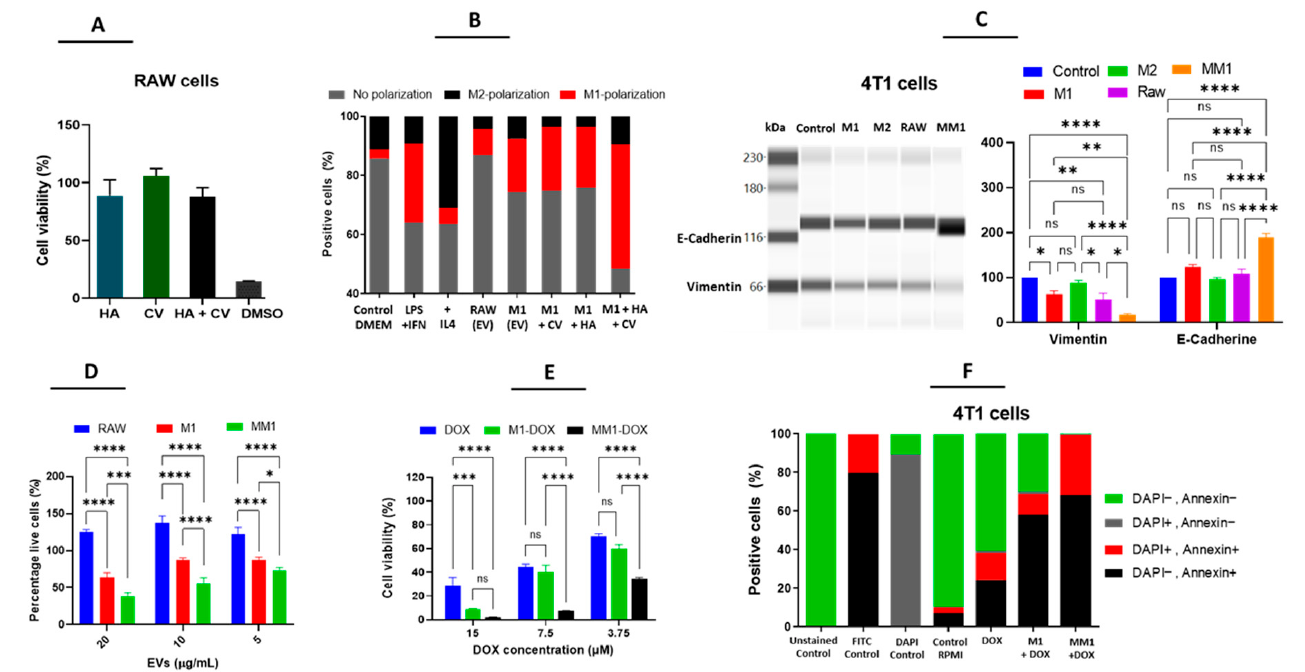
Figure 3. Influence of HA and CV on M1 polarization of macrophages and antitumor potential of EVs in 4T1 cells. ( A ) Cell viability of RAW 264.7 cells treated with HA, CV, or a combination of both. ( B ) Analysis of M1 (by means of CD68 expression) and M2 polarization (by means of CD163 expres- sion) of RAW cells in response to IL-4. LPS + IFN γ , RAW-EVs, and M1-EVs alone and combined with HA, CV, or both. ( C ) Western blot analysis of E-cadherin and vimentin levels in 4T1 cells in response to EVs ( left ) and relative exposure ( right ). ( D ) Cell viability of 4T1 cells in response to RAW, M1, and MM1-EVs. ( E ) Cell viability of 4T1 cells in response to M1 and MM1-EVs loaded with DOX and free DOX. ( F ) Annexin V-FITC/DAPI double staining to evaluate apoptosis induction in 4T1 cells in response to free DOX and DOX-loaded M1 and MM1-EVs. Data are means ± SEM ( n = 3). Non-significant (ns); **** p < 0.0001; *** p < 0.001; ** p < 0.01; * p < 0.05. 3.4. The Combination of HA and CV Potentiates In Vivo Anticancer Activity of M1-Derived